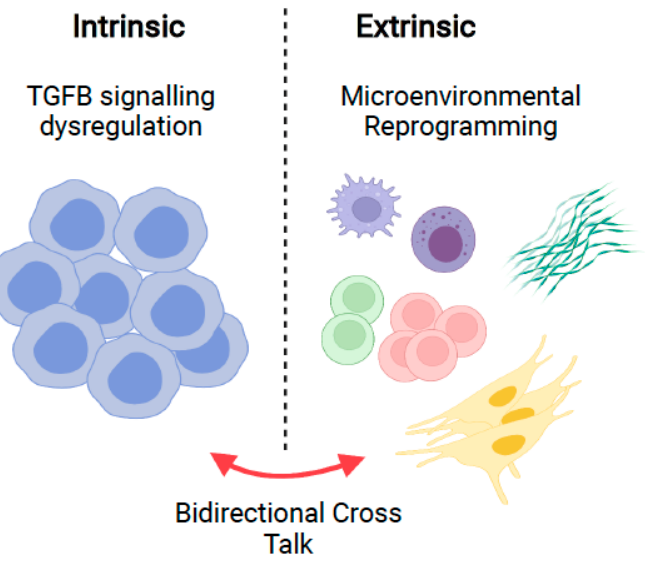
Figure 1. Bone marrow niche effects of TGFB. Heterogenetic regulation of tumour intrinsic signalling pathways and reprogramming of extrinsic bystander cells by TGFB promote disease progression of B-cell malignancies. Figure generated using Biorender.com (accessed 28 February 2022).